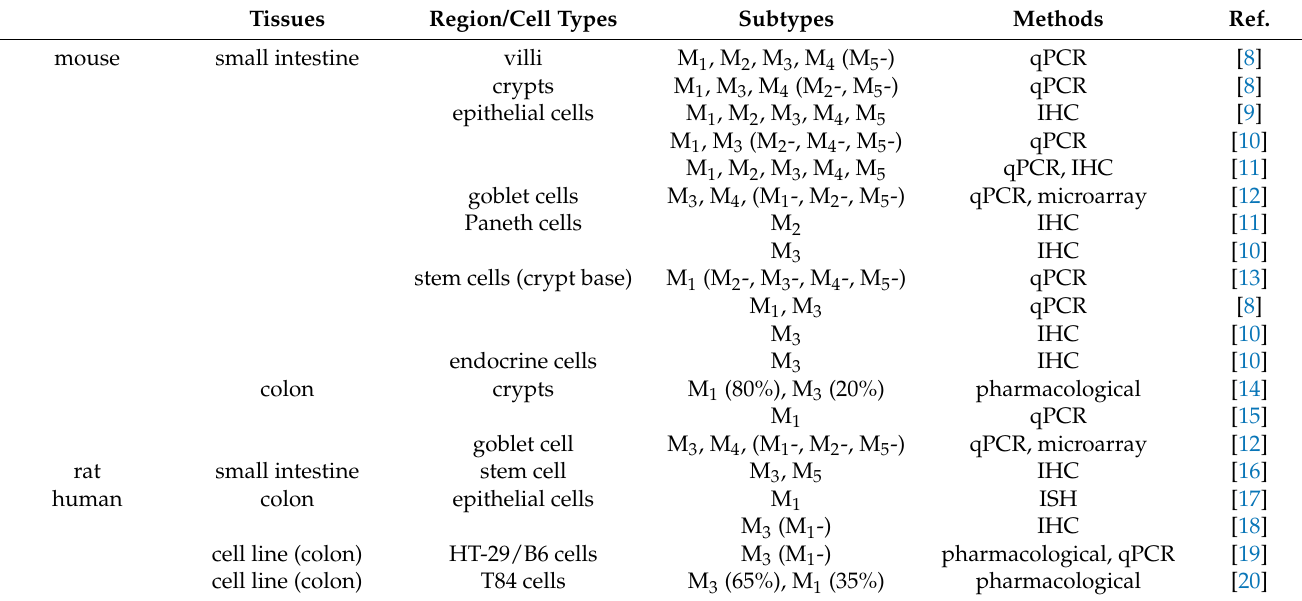
Table 1. mAChR subtypes in intestinal epithelial